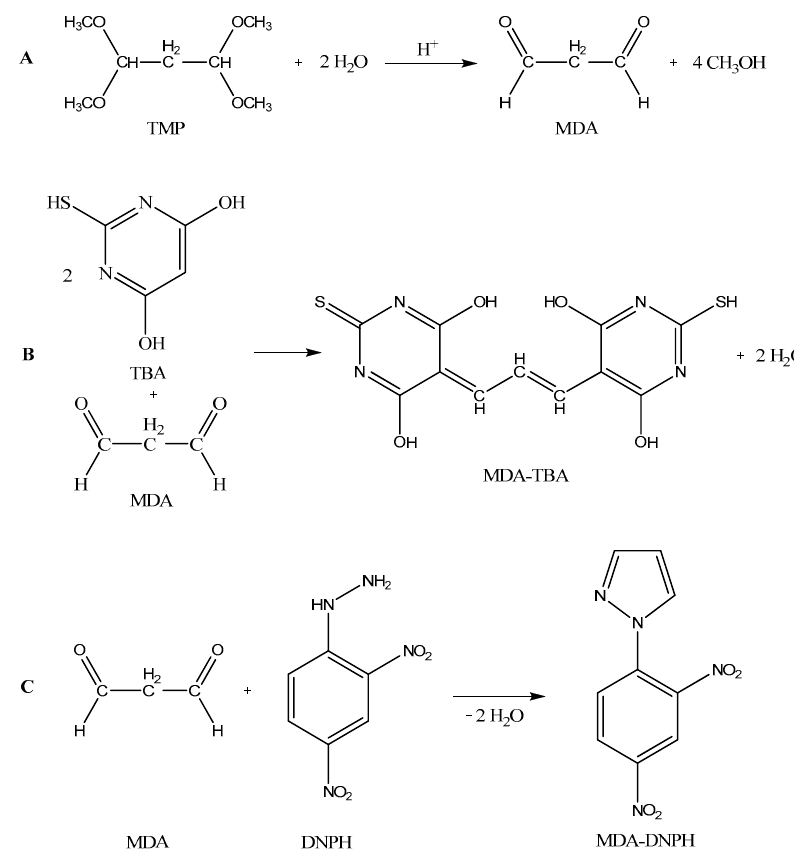
Figure 3. ( A ) The preparation of MDA by acidic hydrolysis of TMP; ( B ) the proposed structure